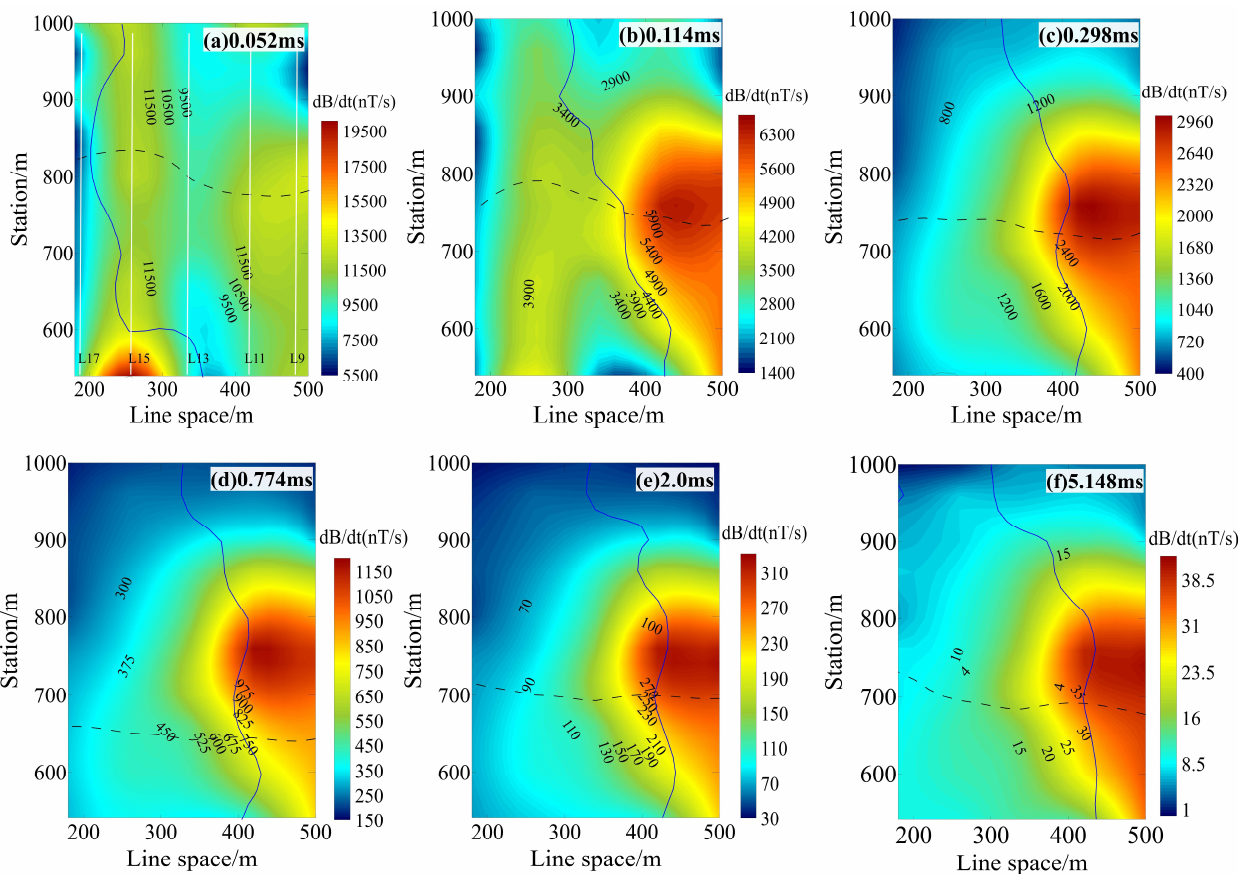
Figure 1. Characteristic curves of 3C TDEM simulation on profile L100 ( a ) and profile L200 ( b ) at sampling time 0.299 ms with the forward resistivity model ( c ).